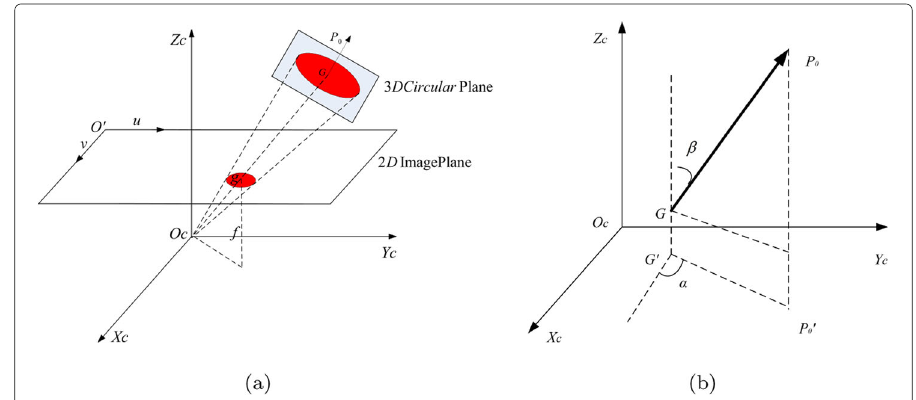
Fig. 1 The projection of circular feature of the 3D object into the image plane ( a ) and a location and orientation of a circular feature ( b